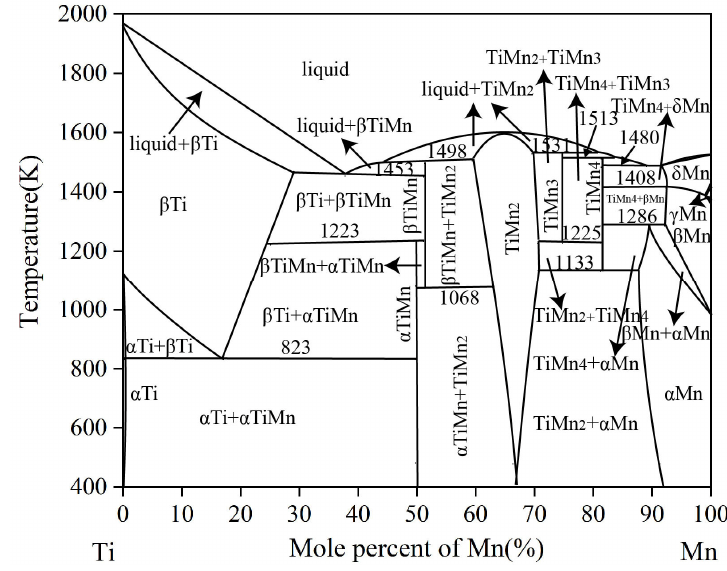
Figure 1. The calculated Ti-Mn phase diagram based on the work of Chen et al. [15]. The Nb-Mn system was thermodynamically assessed by Liu et al. [18], mainly adopt- ing the experimental data obtained by Hellawell et al. [19], Savitskii et al. [20] and Svech- nikov et al. [21] NbMn 2 (C14 Laves phase) is the only stable intermetallic compound in Nb-Mn phase diagram. Based on the previous research work mentioned above, Liu et al. [18] reported the thermodynamic optimization of the Mn-Nb binary system, as shown in Figure 2.